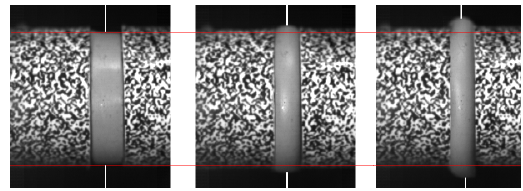
Figure 9. Comparison of intact and deformed state of polyurethane putty specimen.